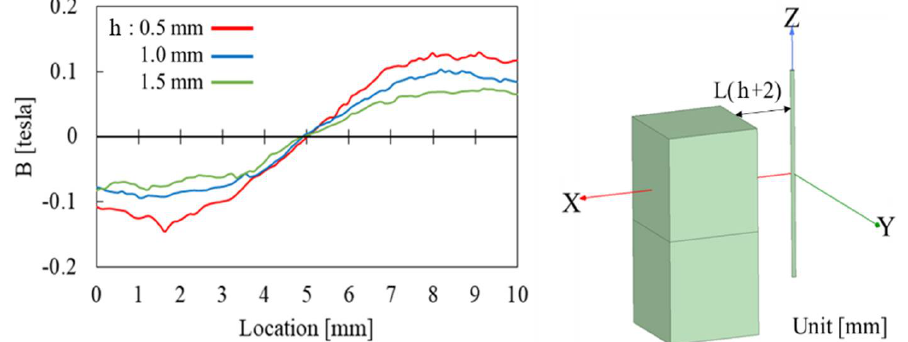
Figure 15. Simulation results of the magnetic flux density through the Wiegand wire in the radial axis when h = 0.5, 1.0, 1.5 mm.